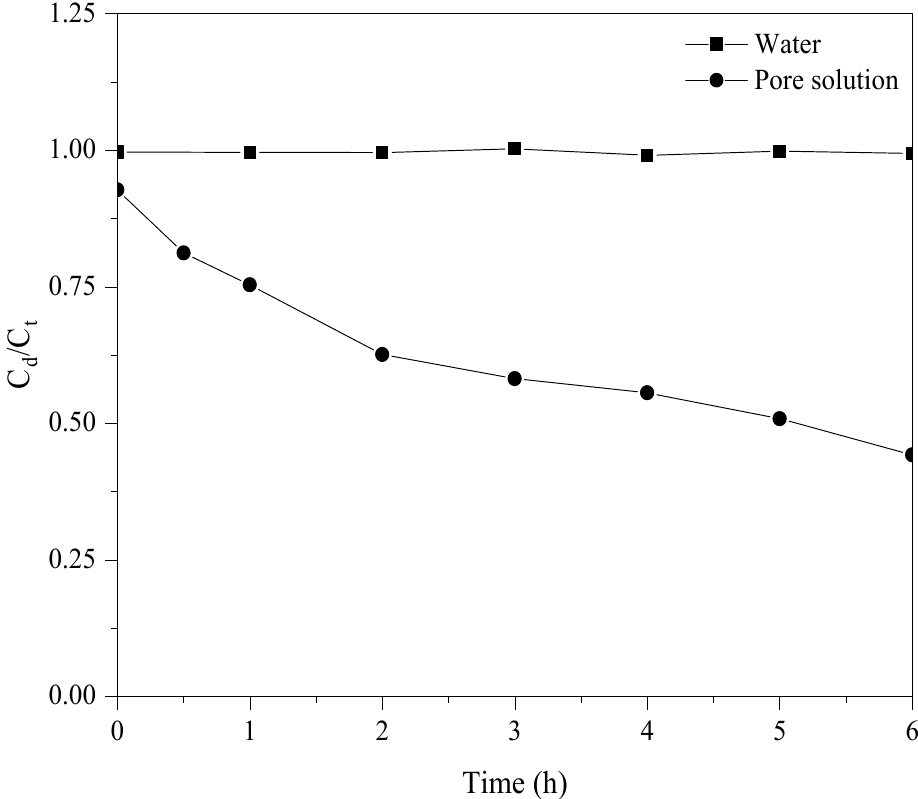
Figure 3. Stability of CNT dispersions in water and simulated cementitious pore solution after 6 h.